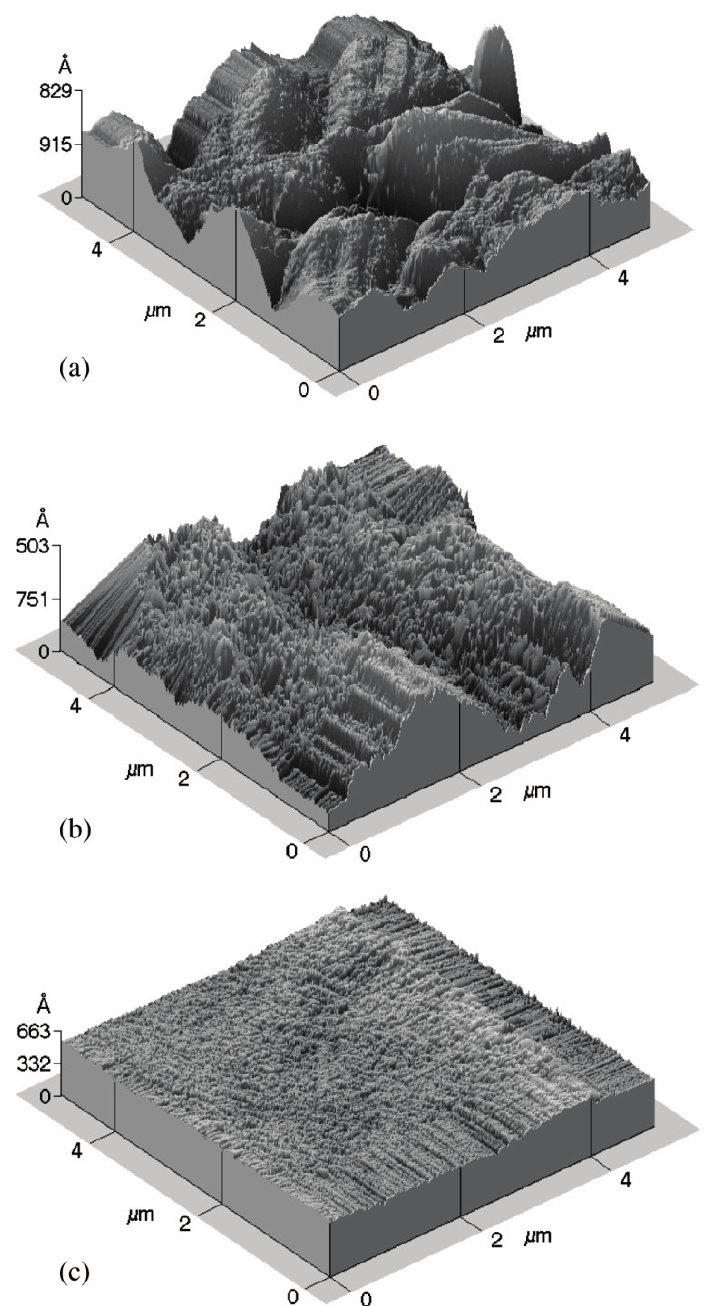
Figure 3. Atomic force microscopy (AFM) images of ( a ) untreated, ( b ) micro-roughened and ( c ) nano-roughened polydimethylsiloxane (PDMS) films. Reprinted with permission from IOP, 2009